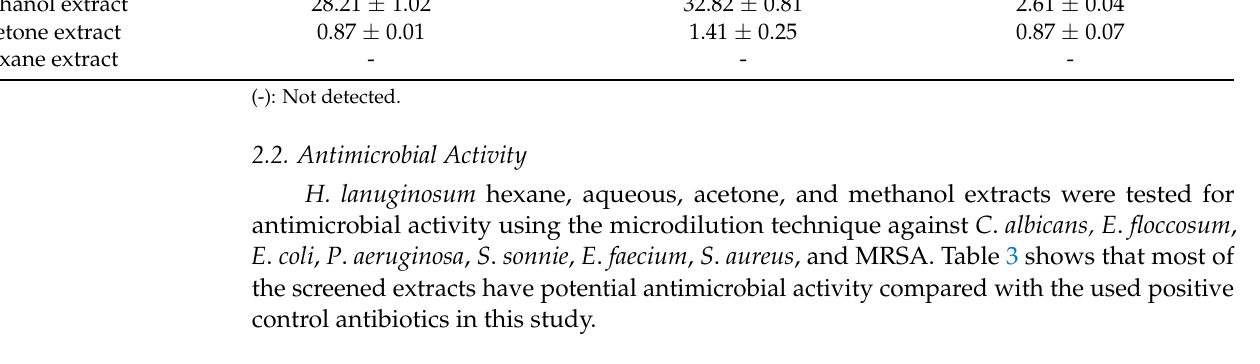
Table 3. Antimicrobial activity MIC values ( µ g/mL) of methanol, aqueous, hexane, and acetone extracts of H. lanuginosum